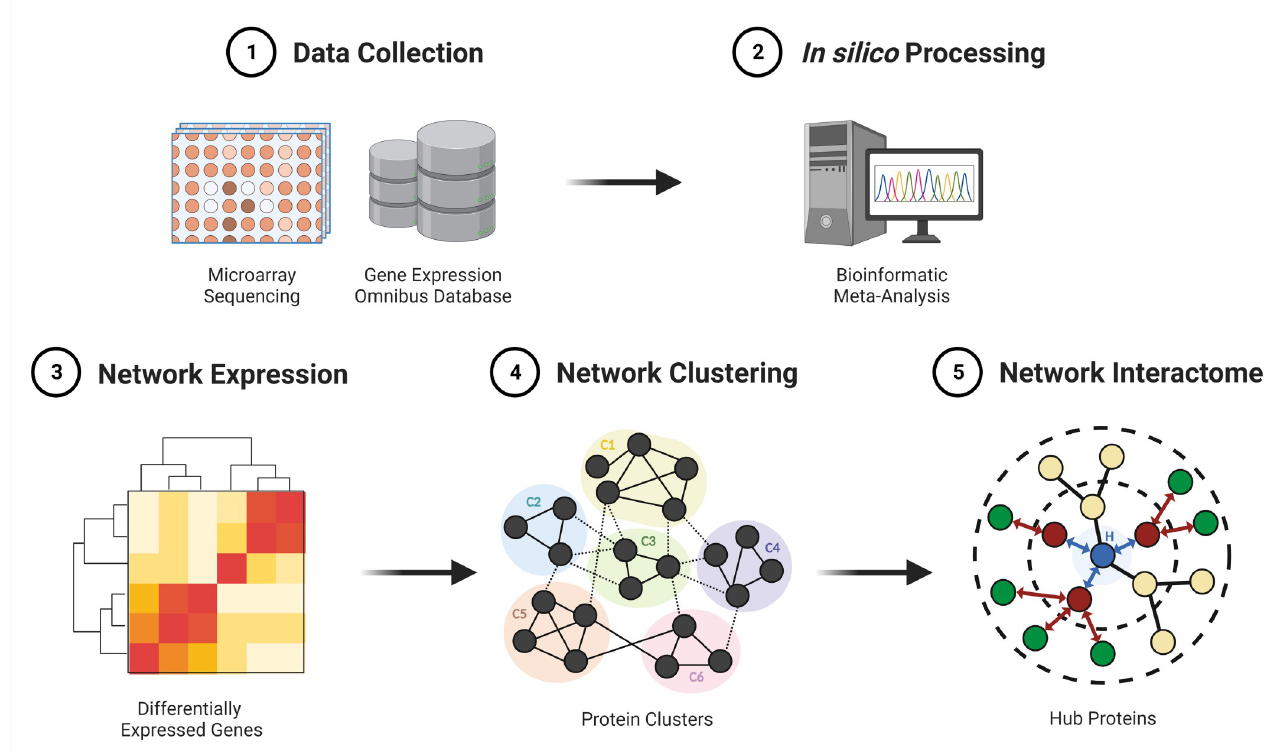
Fig 1. Methodological summary of the stepwise workflow employed in our study. The literature was initially screened through the Gene Expression Omnibus database for publicly available microarray datasets containing skeletal muscle samples from older and lung samples from patients with non-small cell lung cancer (NSCLC) (1). Eligible gene expression profiles were thereafter integrated and meta-analysed using the random effect model (2). Thenceforth differentially expressed genes (DEGs) with the strongest average effect across all included datasets were derived (3). Highly clustered (C) proteins of significant and overlapping DEGs between the two conditions were identified using the Molecular Complex Detection and mapped using The Search Tool for the Retrieval of Interacting Genes (4). The interactome interference of the shared sub-networks was evaluated using the intersection of 11 local and global-based topological algorithms from CytoHubba and central hub objects as potential markers of musculoskeletal ageing and NSCLC disease progression were derived (5). C: Cluster; H: Hub.